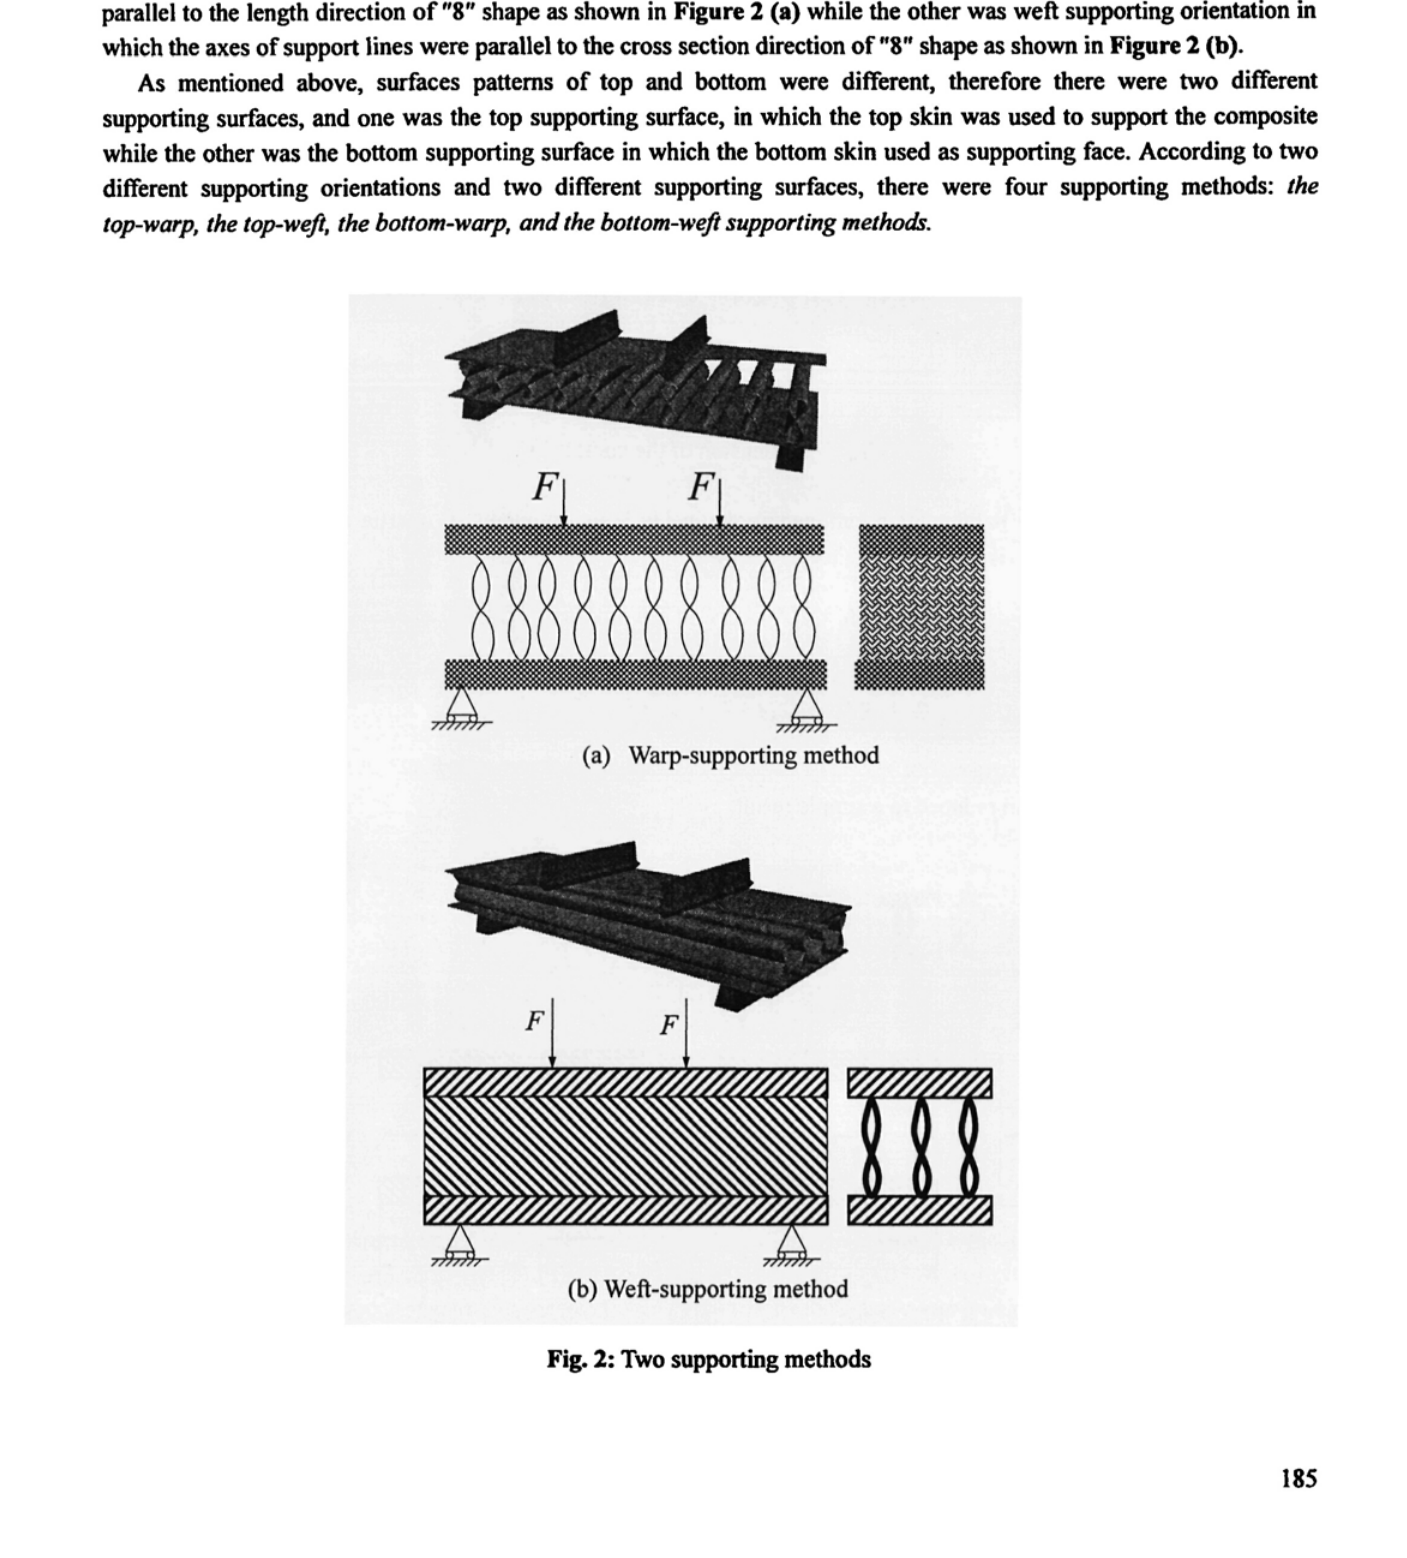
Fig. 2: Two supporting